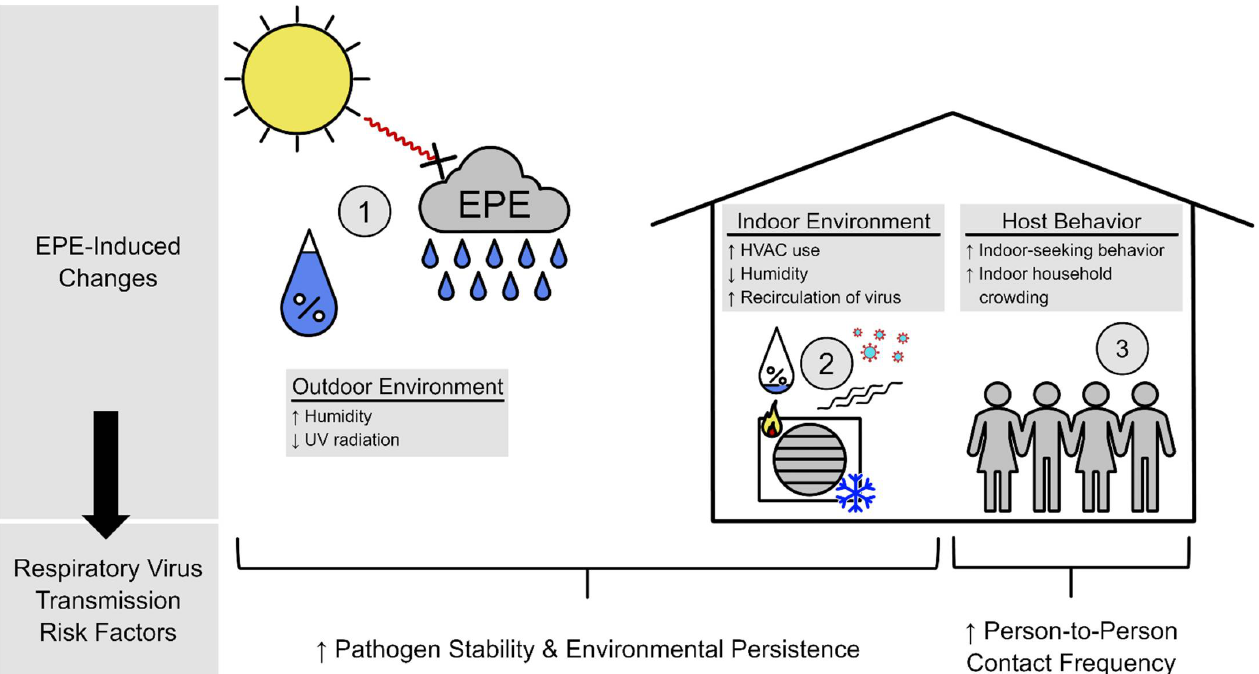
Figure 1. Conceptual framework of the impact of extreme precipitation events (EPEs) on infectious respiratory viruses. EPEs alter (1) the natural environment by increasing humidity and decreasing UV radiation, (2) indoor environments by increasing heating, ventilation, and air conditioning (HVAC) system use which in turn lowers humidity and increases recirculation of virus-laden droplets and aerosols, and (3) human host behavior by prompting increased indoor-seeking behavior and household crowding. Changes to the outdoor and indoor environments increase pathogen stability and persistence in outdoor and indoor environments and changes in host behavior increase person- to-person contact frequency, two important factors in favoring increased transmission